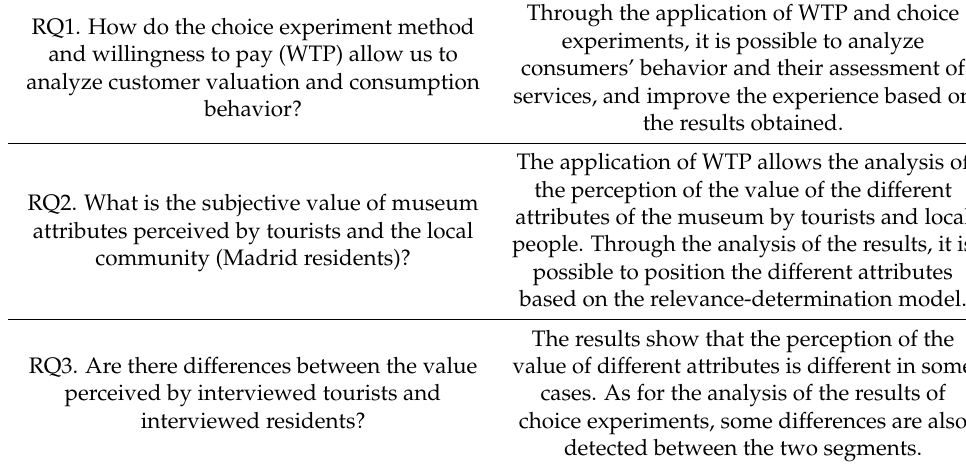
Figure 5. A proposed model: attribute evaluation in museums. The results obtained allow us to answer the initial research questions proposed, as summarised in Table 7. Table 7. Research questions and responses.